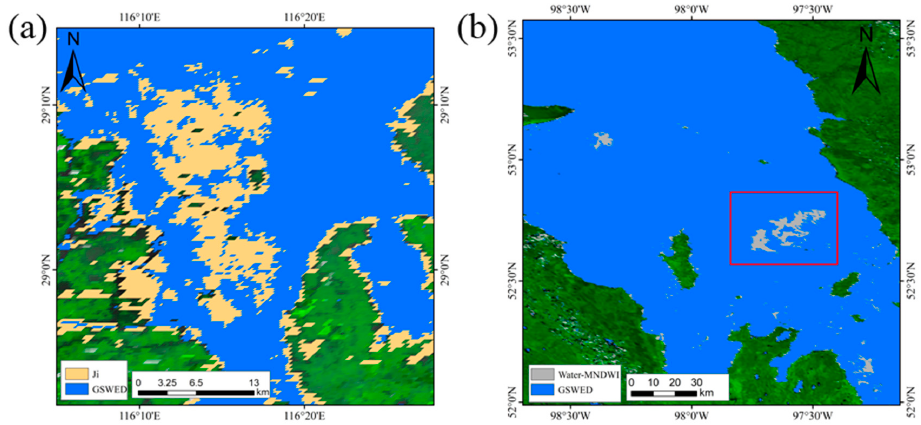
Figure 12. ( a ) Water extracted by short wave infrared band [26] and the global surface water extent dataset in Poyang Lake on 26 June 2015 and ( b ) water extracted by the modified normalized difference water index and global surface water extent dataset in Winnipeg Lake in North America on 28 July 2015.